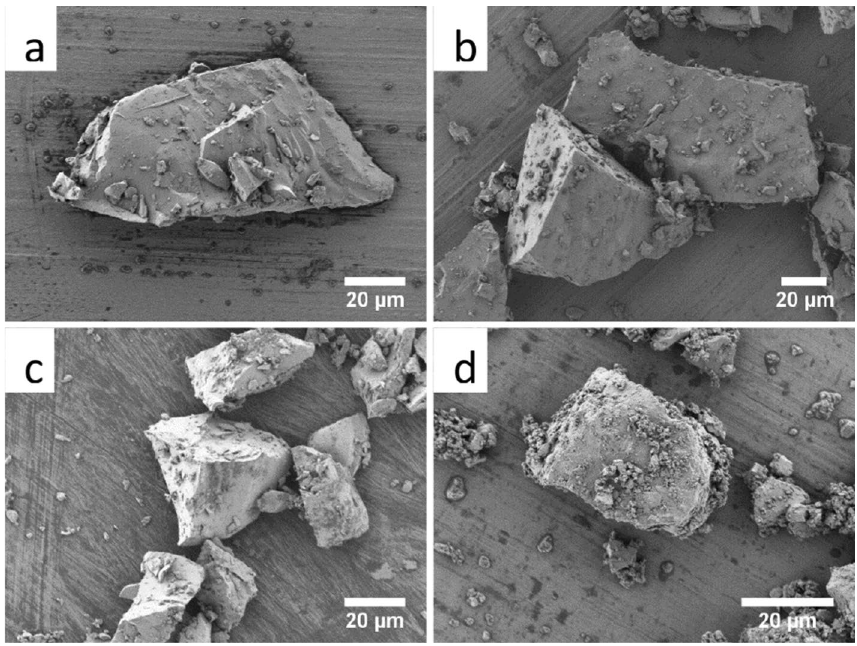
Figure 1. Scanning electron microscopy (SEM) showing the morphology of the sintered BG particles investigated in this study, namely ( a ) ICIE16-BG, ( b ) 3B-BG, ( c ) 4B-BG and ( d )